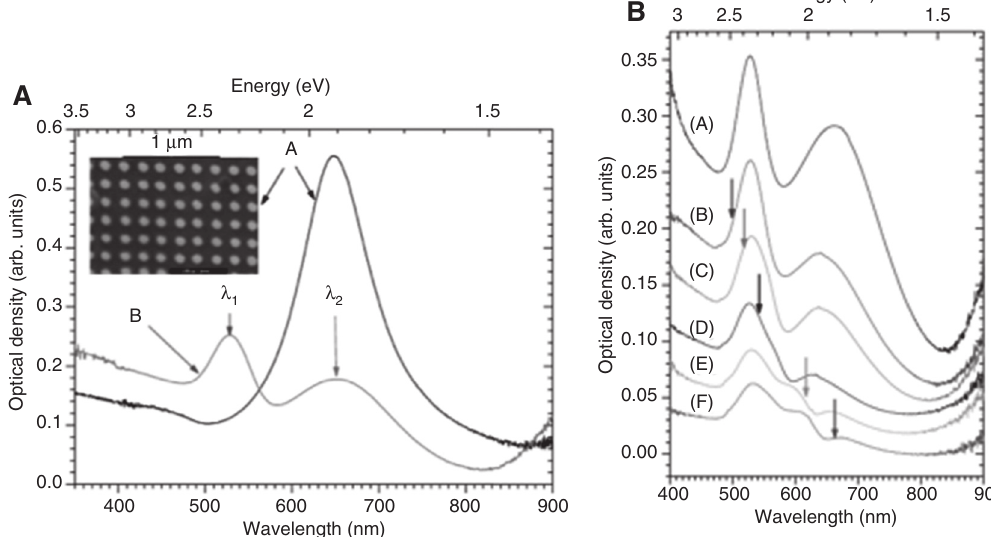
Figure 9: (A) Extinction spectrum of arrays of gold oblate spheroidal particles in the experiment of Félidj et al. [30], deposited on ITO, major axis 110 nm parallel to the ITO substrate, minor axis 60 nm perpendicular to the ITO, interparticle spacing 200 nm (spectrum A ), and a 20-nm gold film, major axis 120 nm parallel to the gold film, minor axis 44 nm perpendicular the gold film, interparticle spacing 200 nm (spectrum B ). The inset displays a scanning electronic microscopy image of the array of gold particles on ITO. (B) Extinction spectra of arrays of gold oblate spheroidal particles identical to those of spectrum B , deposited on a 20-nm gold film for different spacing between particles: spectrum A : 180 nm, spectrum B : 200 nm, spectrum C : 230 nm, spectrum D : 250 nm, spectrum E : 300 nm, spectrum F : 320 nm. Spectrum F is vertically lowered by 0.03 density unit for clarity. Arrows display the wavelengths at which the Bragg scattering condition is fulfilled. Reprinted figure with permission from N. Félidj, J. Aubard, G. Lévi, J. R. Krenn, G. Schider, A. Leitner, and F. R. Aussenegg, Phys. Rev. B, 66, 245407, 2002. Copyright (2002) by the American Physical